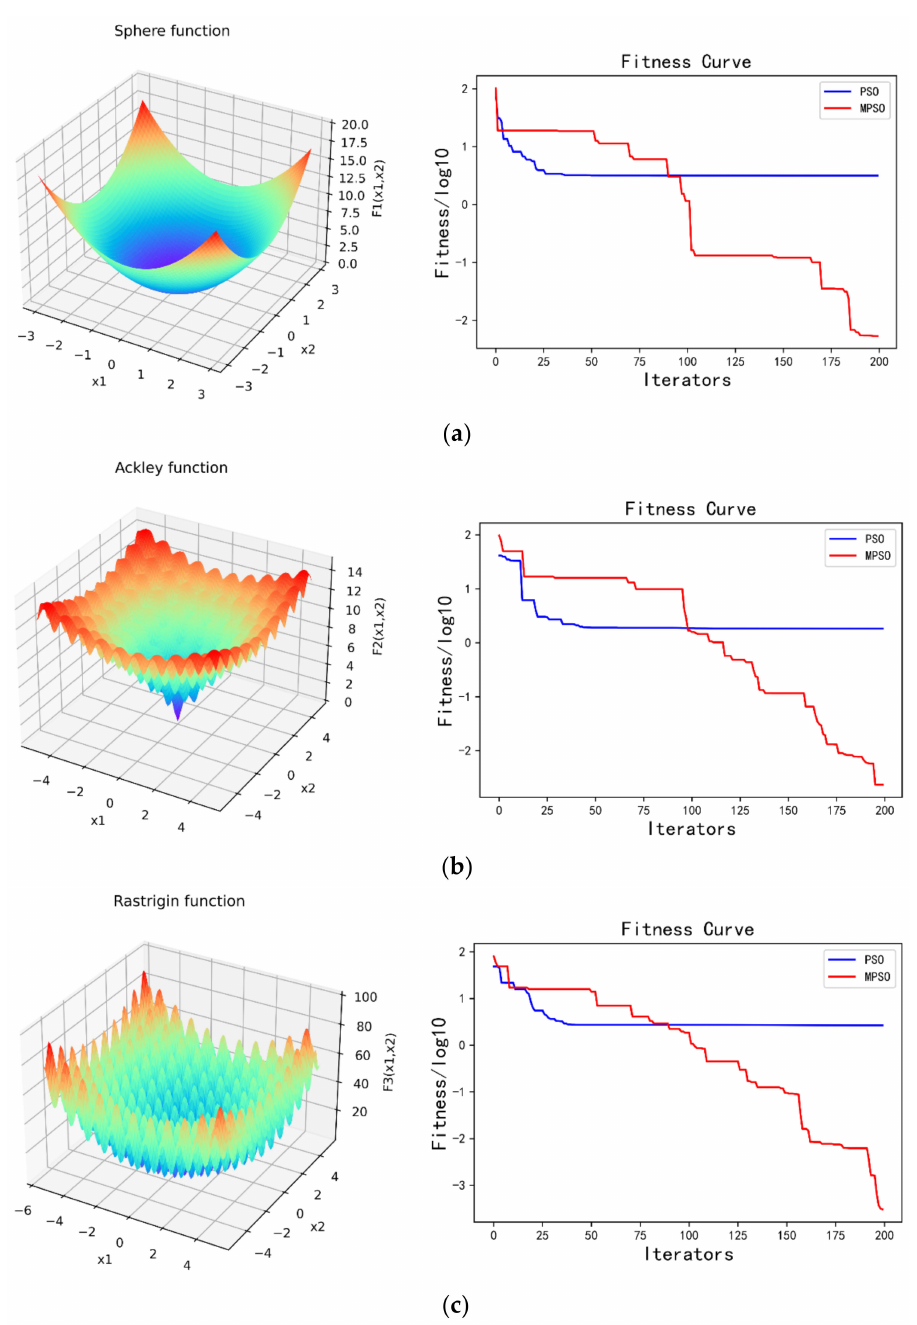
Figure 1. ( a ) Sphere function; ( b ) Ackley function; ( c ) Rastrigin